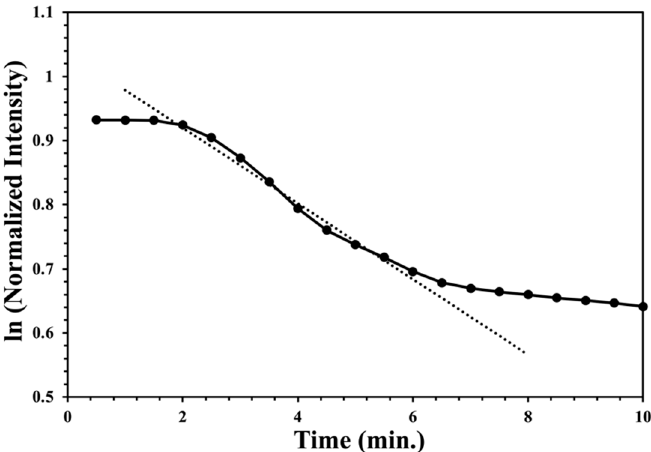
Figure 6. The natural logarithm of normalized reflected intensity with time from an XploSafe PS test-strip during the peroxide exposure to a hydrogen peroxide gas at a concentration of 28 ppm. The line is the linear regression used to determine the rate constant. Table 1. The phenomenological first-order rate constants and error bars determined at different hy- drogen peroxide ppm.